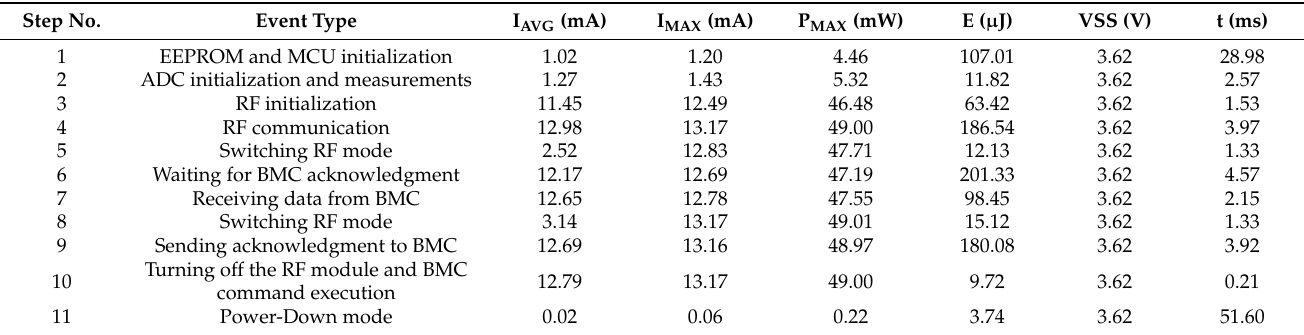
Table 3. Power requirements of the SU in normal operation mode.